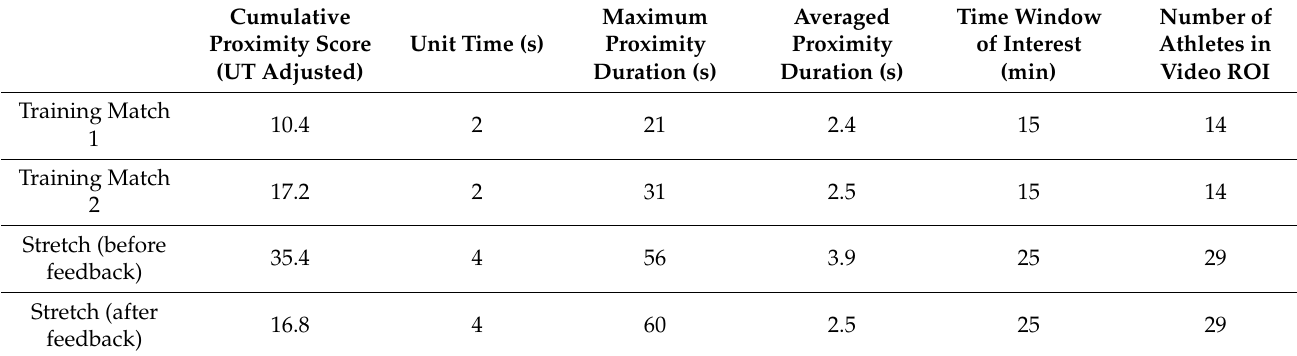
Table 3. Situation specific proximity scores.